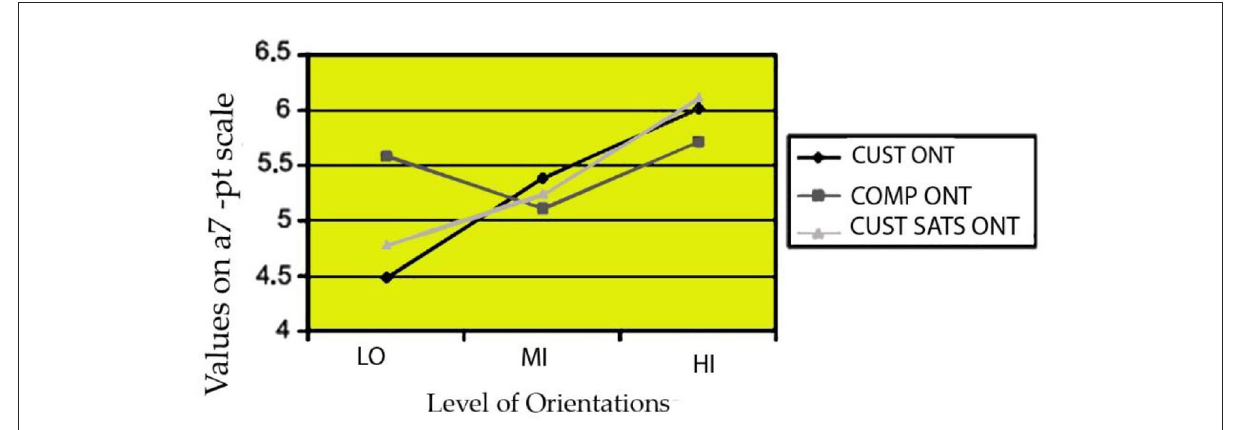
FIGURE13 Relationship between corporate performance and degree of